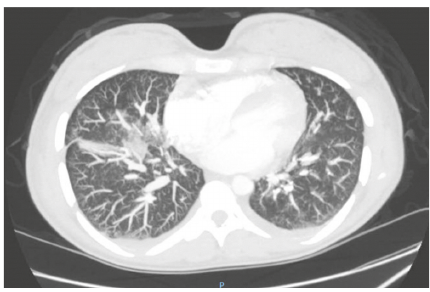
Figure 2: Chest computed tomography angiography (CTA) on the day of admission noting patchy infiltrate in the right middle and lower lung lobes and small bilateral pleural